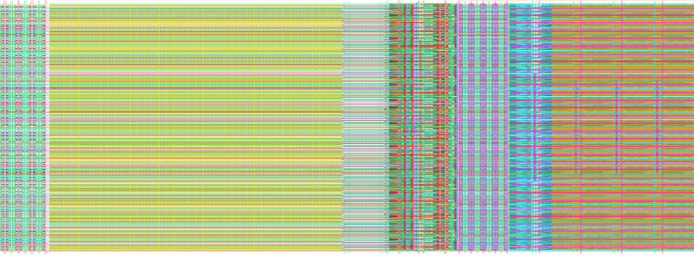
Figure 10. ADC overall layout design.